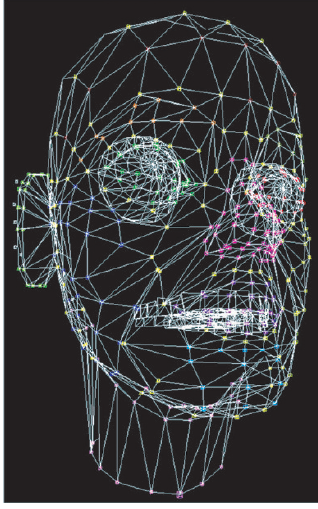
Figure 2: Generic 3D head